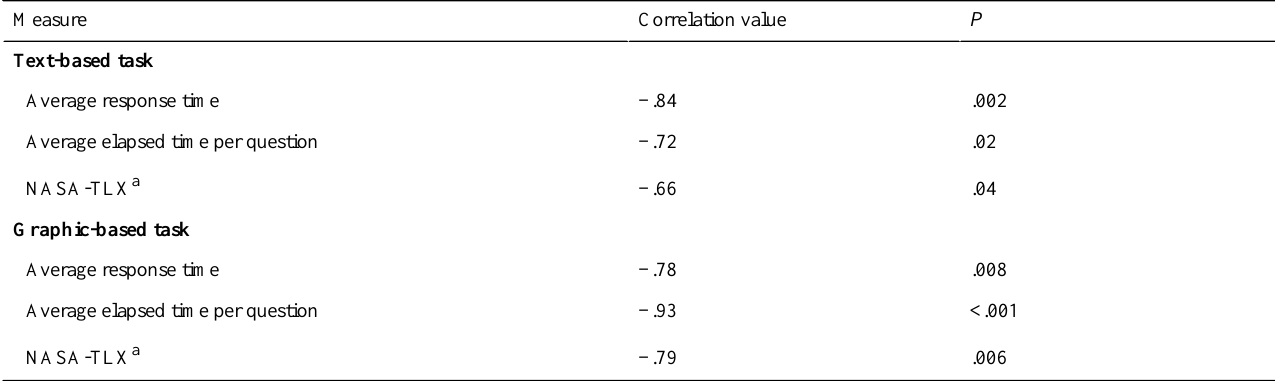
Table 4. Correlation analysis for the text- and graphic-based